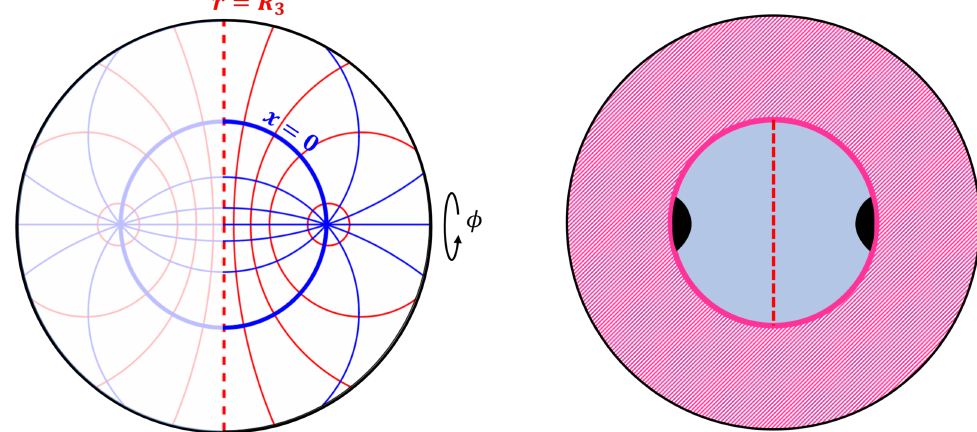
Figure 2 . Left : AdS 4 C-metric (4.1) with µ = 0 , in ( r, x ) coordinates in a slice at t = 0 and constant φ . Lines of constant x are blue arcs; lines of constant r are red arcs (full circles for 0 < r < ‘ ). The thick blue circle x = 0 is where we place the dS 3 brane; its interior is 0 < x ≤ 1 , with x = 1 the φ axis of rotation. The exterior region x < 0 is excluded in the braneworld construction. The vertical red dashed line is the horizon at r = R 3 . Its intersection with the brane yields a dS 3 cosmological horizon. The coordinates only cover half of the disk, with the other half being obtained through analytic continuation. Right : construction of black holes on a dS 3 braneworld when µ > 0 . The dashed magenta region x < 0 is excluded. The black hole horizon and the cosmological horizon are at constant r